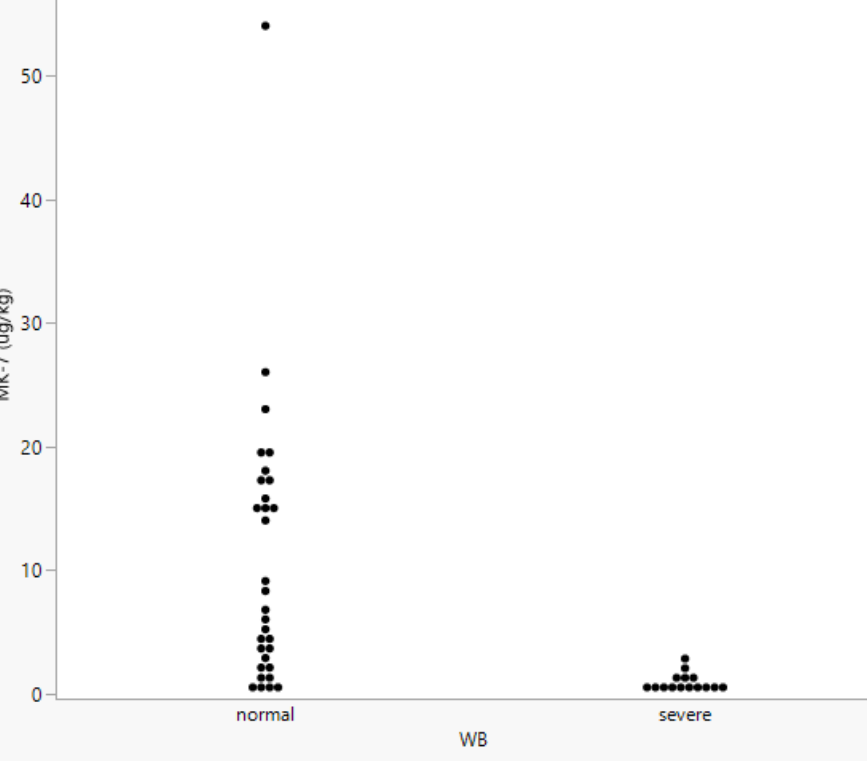
Figure 5. Vitamin K 2 (as MK-7) measurement in a separate group of birds scored for Wooden Breast (WB).